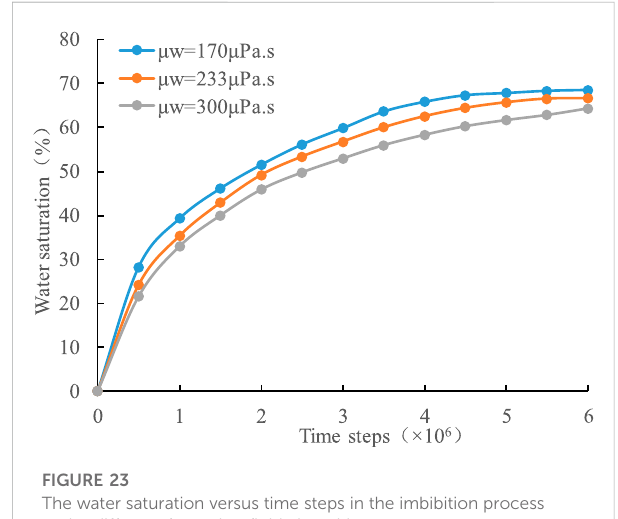
FIGURE 23 The water saturation versus time steps in the imbibition process under different fracturing fl uid